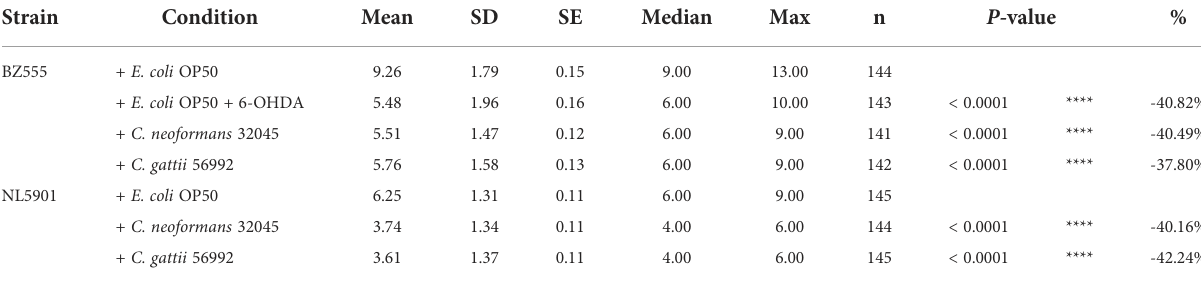
TABLE 1 Mean lifespan of C. elegans strain BZ555 and NL5901 upon C. neoformans 32045 or C. gattii 56992 infections. Strain Condition